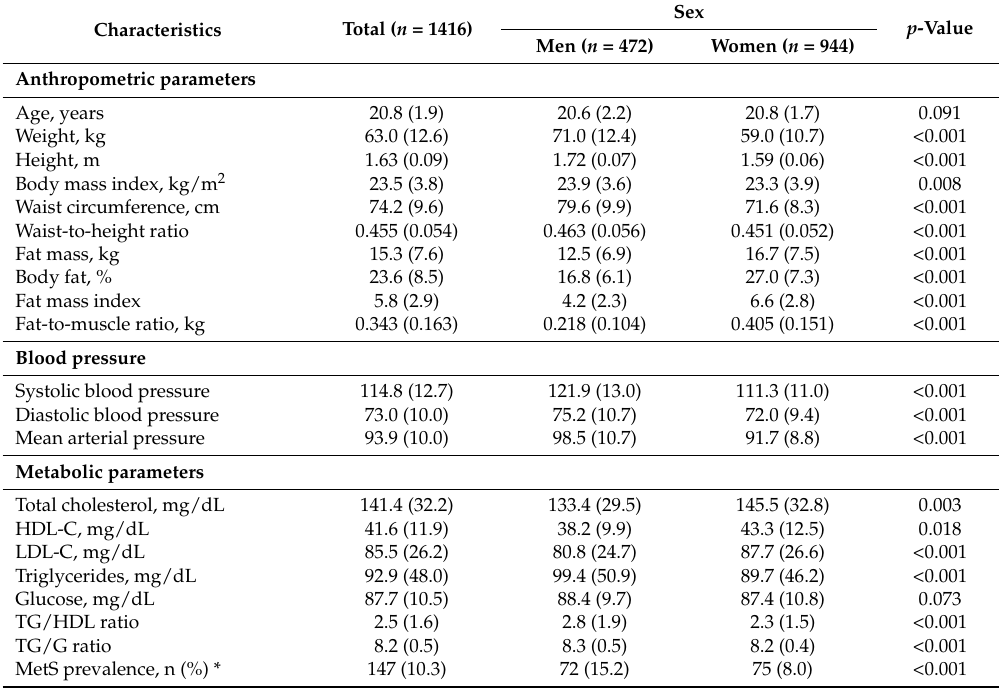
Table 1. Characteristics among a sample (mean (standard deviation (SD)) or frequency (%)).